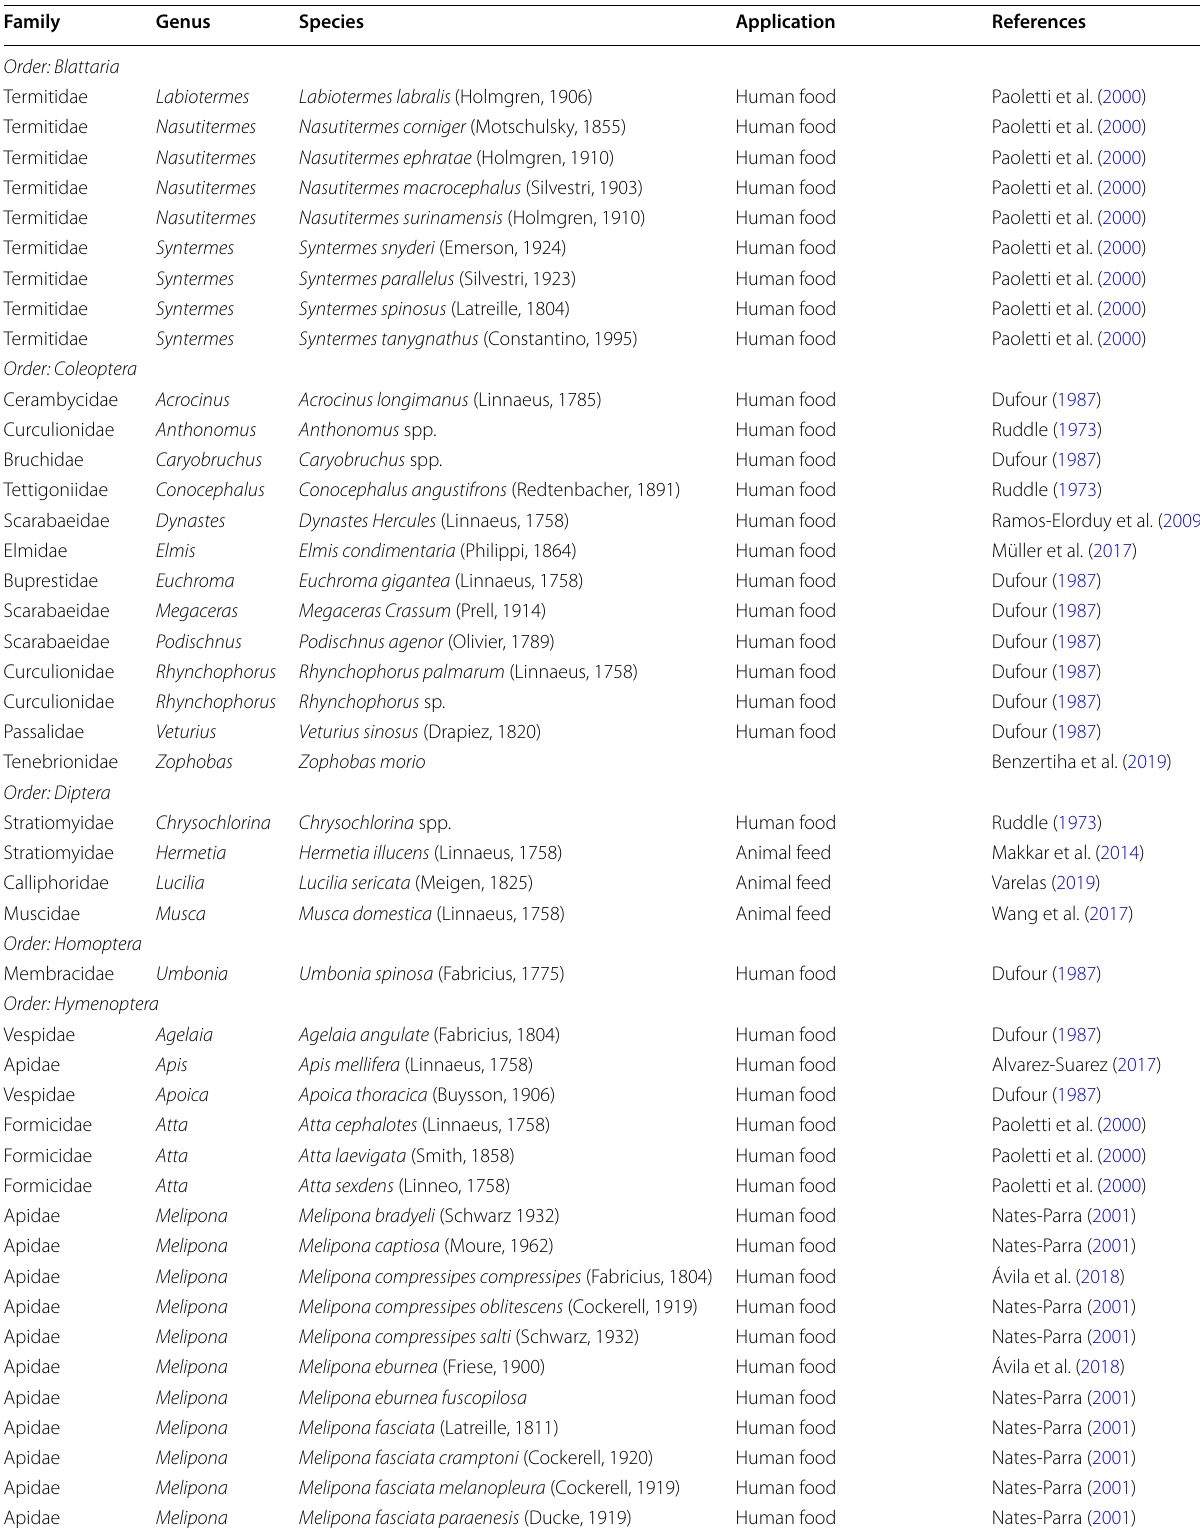
Table 1 Insects used as food and feed Family Genus